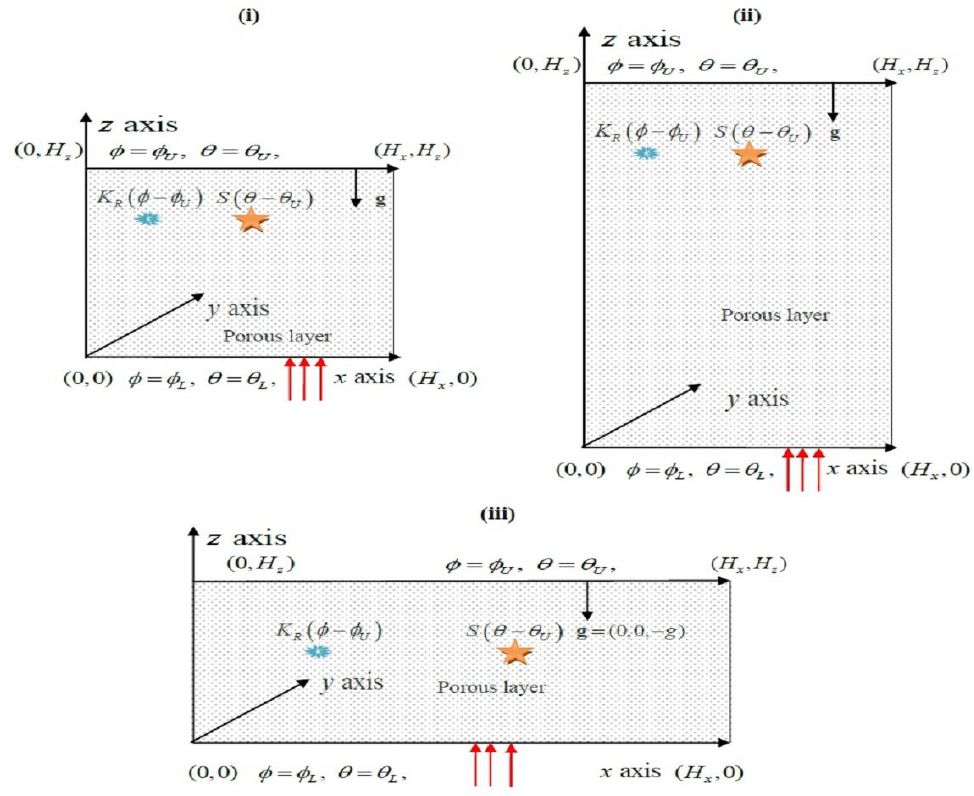
Figure 1. Physical configuration of the problem: ( i ) square enclosure, ( ii ) slender vertical enclosure, and ( iii )